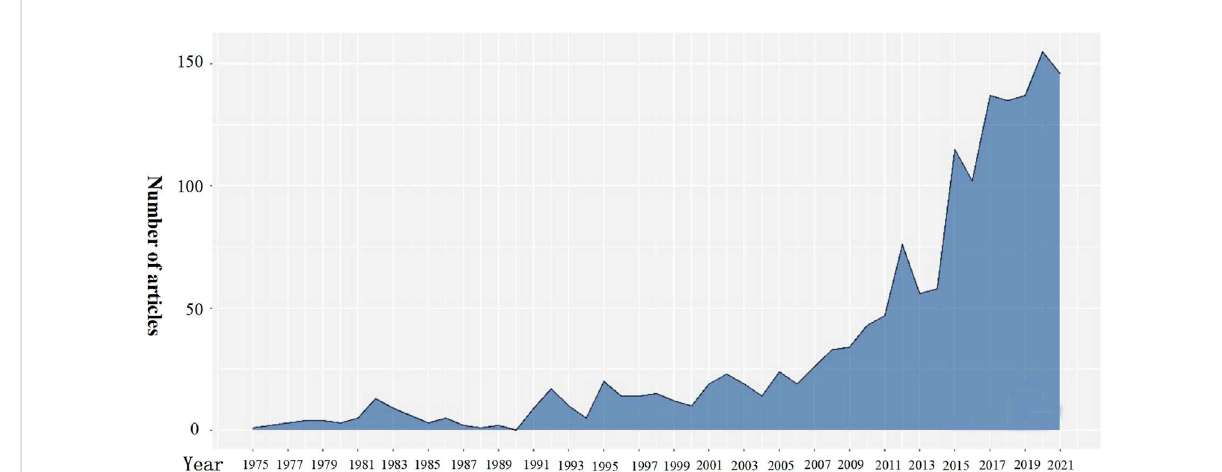
Number of rural settlements research articles from 1973 to